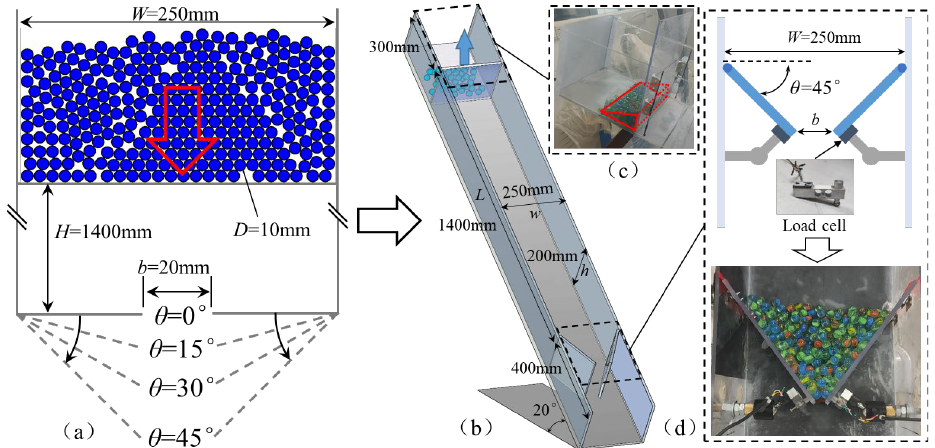
Figure 1. ( a ) schematic diagram of DEM method simulating flume model; ( b ) schematic diagram of flume experimental device; ( c ) particle hopper; ( d ) baffle impact force measuring sensor.